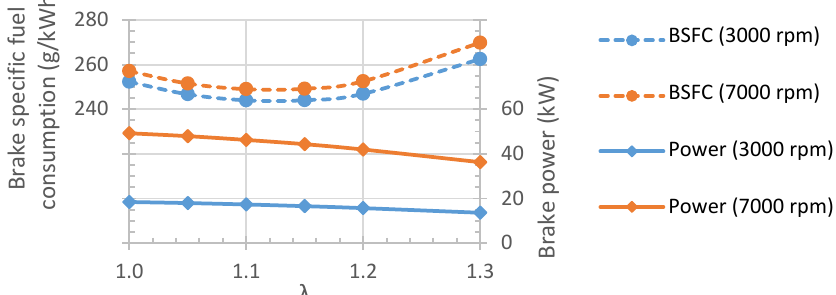
Figure 6. Simulation results for brake specific fuel consumption and power of the stock engine as a function of mixture strength, λ.